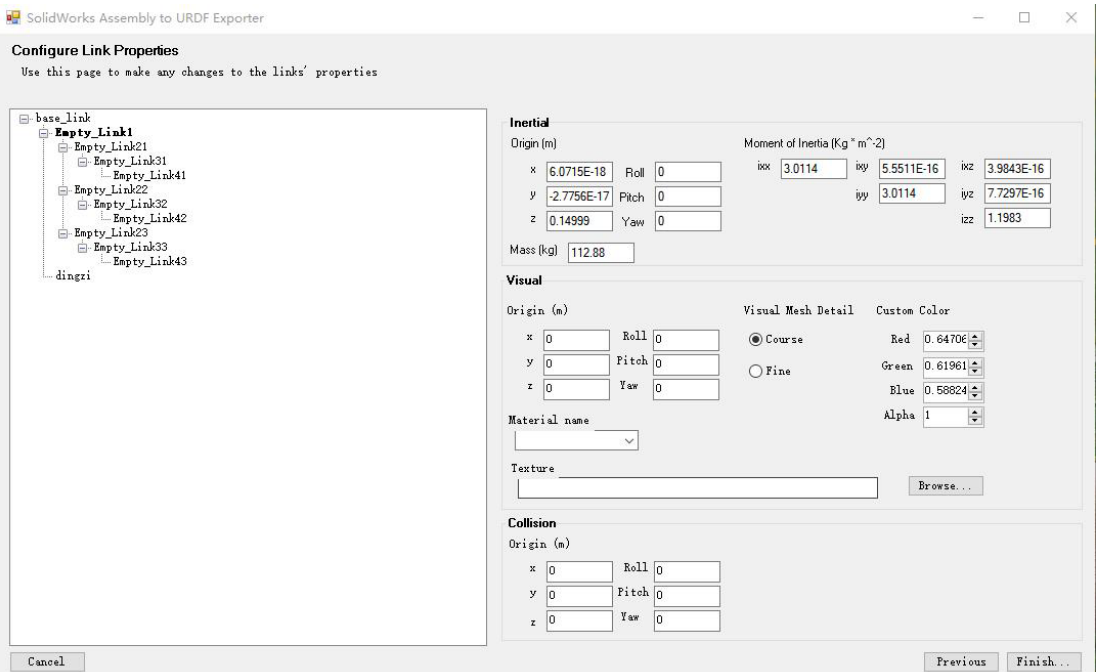
Figure 12. Link configuration